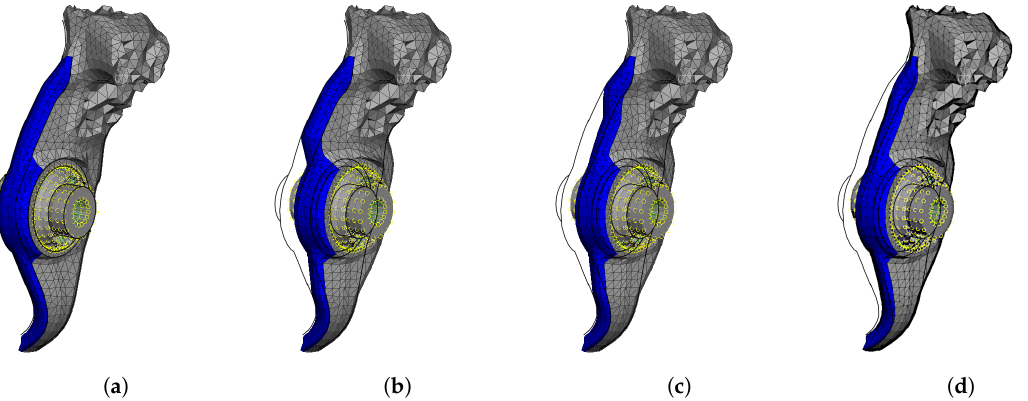
Figure 5. Visualization of smoothing operation after performing the displacement of one kinematic hard point through Box Morphing. The hard point under investigation is located in the center of the bushing, identified by yellow circles highlighting its nodes. The black outline represents the undeformed geometry in ( a ). ( a ) Undeformed. ( b ) Morphed. ( c ) 1st smoothing. ( d ) 2nd